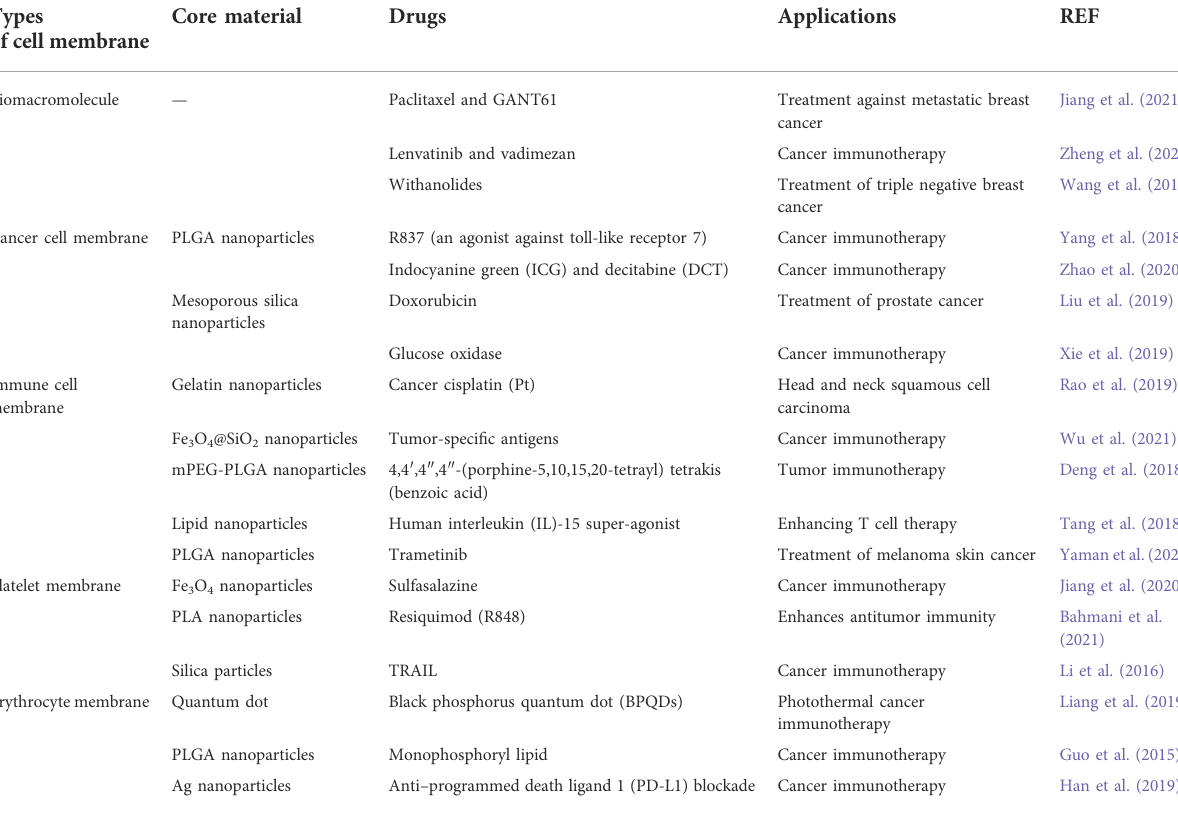
TABLE 1 Summary of cell membrane-based biomimetic nanoparticles for cancer